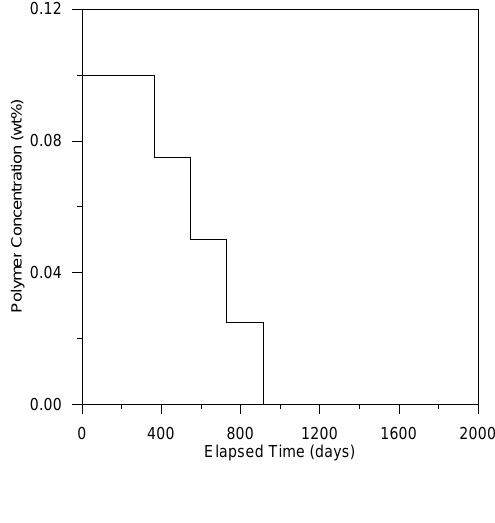
Figure 1. History of polymer concentration in the injecting water.